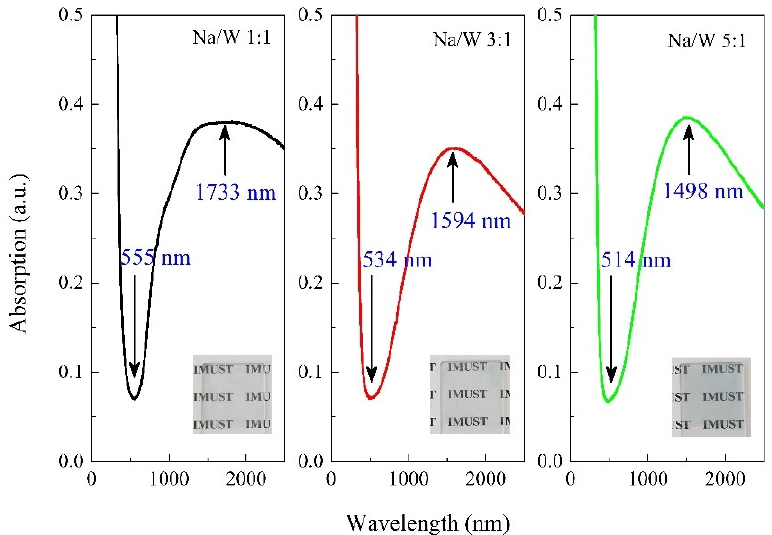
Figure 6. Absorption spectra of Na x WO 3 nanoparticles with Na/W ratio of 1:1, 3:1 and 5:1. Inset shows the photograph of the thin film samples used in the test.